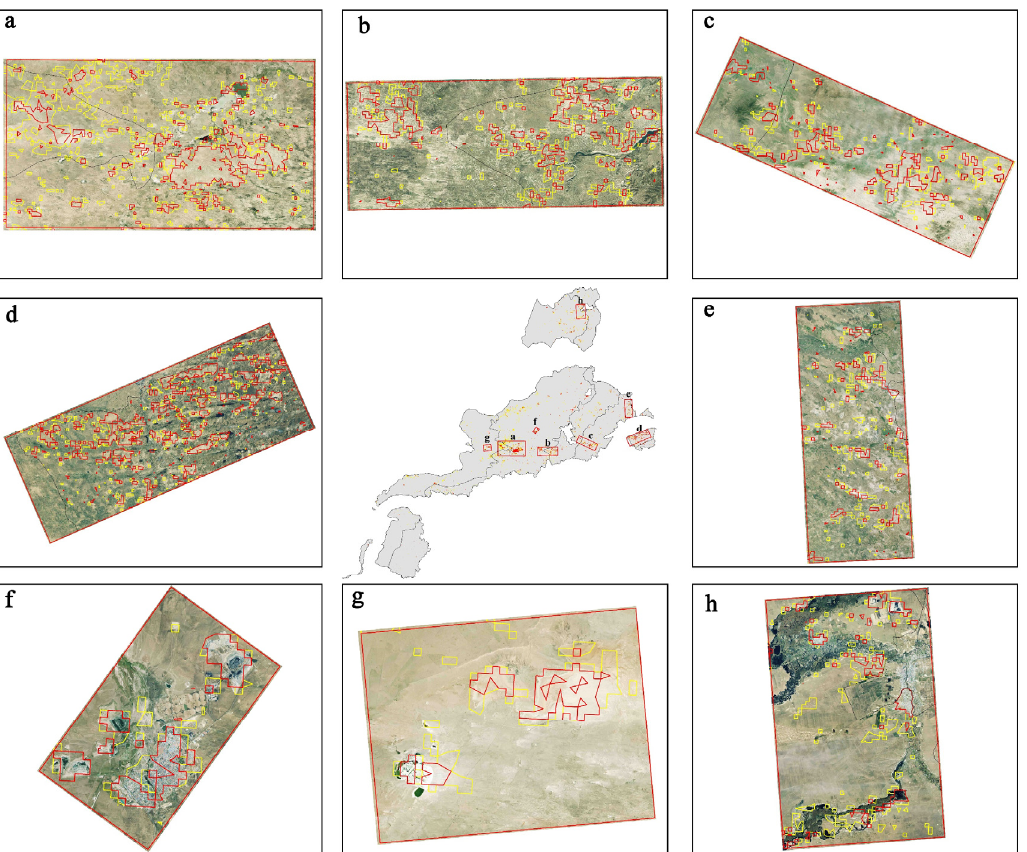
Figure 6. Google Earth images from 2017 showing the normalized difference vegetation index (NDVI) degraded area. ( a – h ) show typical areas of significant degradation, where red and yellow lines represent extremely significantly degraded and significantly degraded areas, respectively.